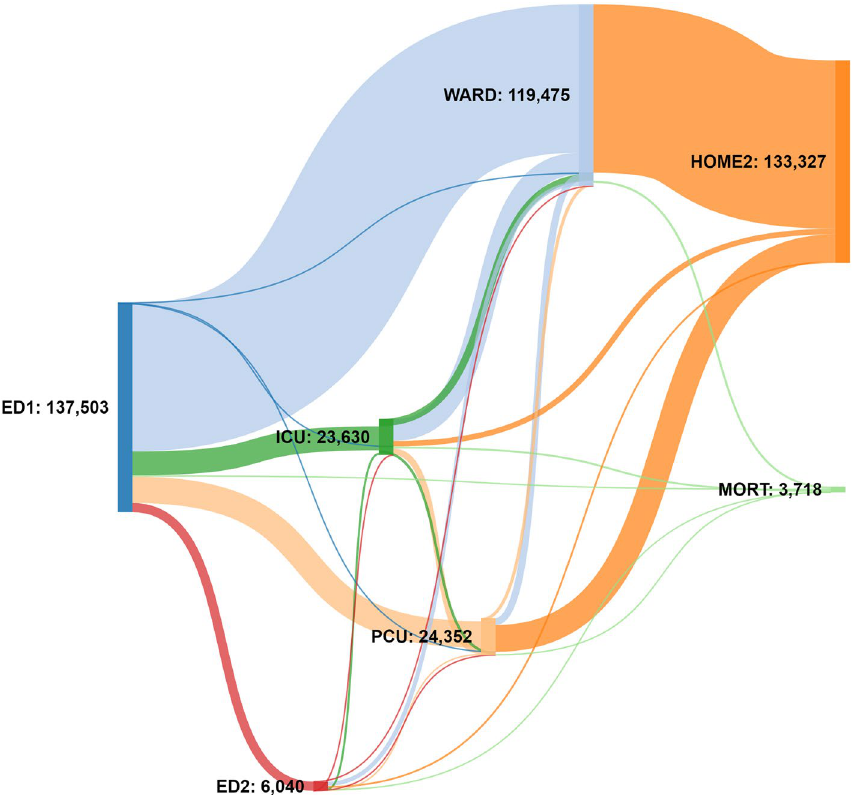
Figure 1. Sankey diagram visualizing the patient pathways. Pathways are colored by the receiving location and width of line represents the number of patients. All ED visits resulting in hospitalization, transfer or death are followed through the system to their endpoint. ED visits that resulted in discharge home directly from the initial ED attendance are excluded from this representation. Transfers to a further emergency department (ED2) are shown in red. The main journey of ED to ward to home is clearly displayed but with alternative ED to ICU or PCU to ward and then home contributing most of the remaining